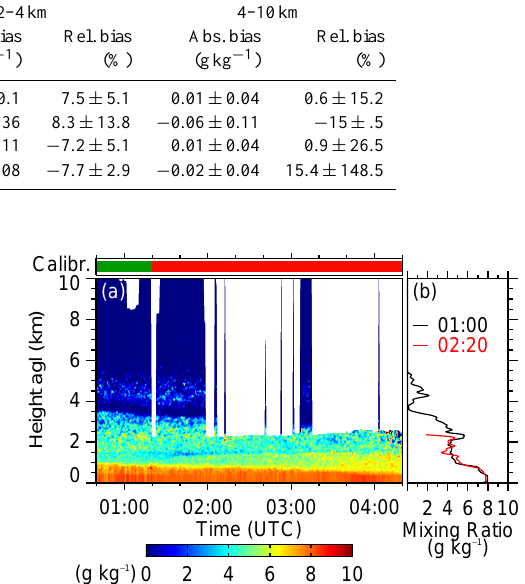
Figure 10. (a) Height-time display of the water vapour mixing ratio from a Polly XT measurement on 16 April 2013, 00:40UTC. White areas are regions in or above clouds without any water vapour in- formation. The bars on the top indicate which profiles are calibrated (green) based on the current IWV from MWR. The red bars de- note profiles which are calibrated with the averaged calibration fac- tor from the last clear sky 20min interval (red). (b) Profiles of the 20min intervals at 01:00UTC (black) and 02:20UTC (red).